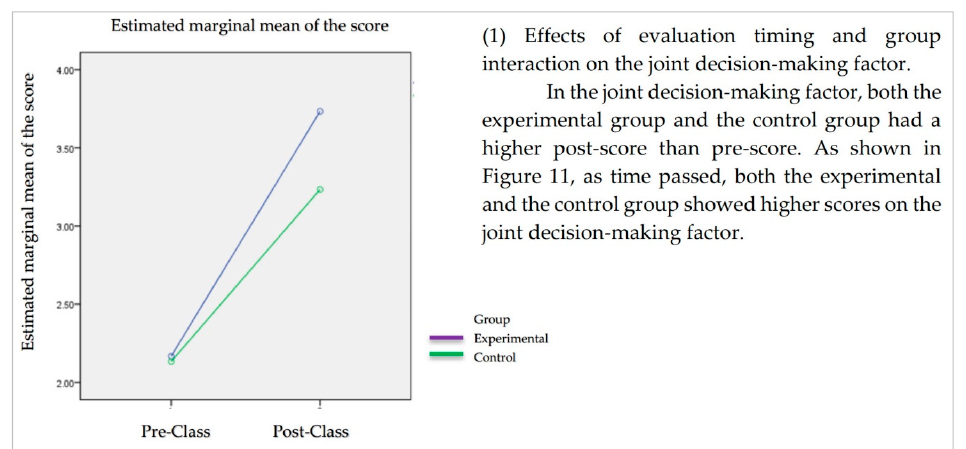
Figure 9. Effect of timing and group interaction on Joint Decision-Making.